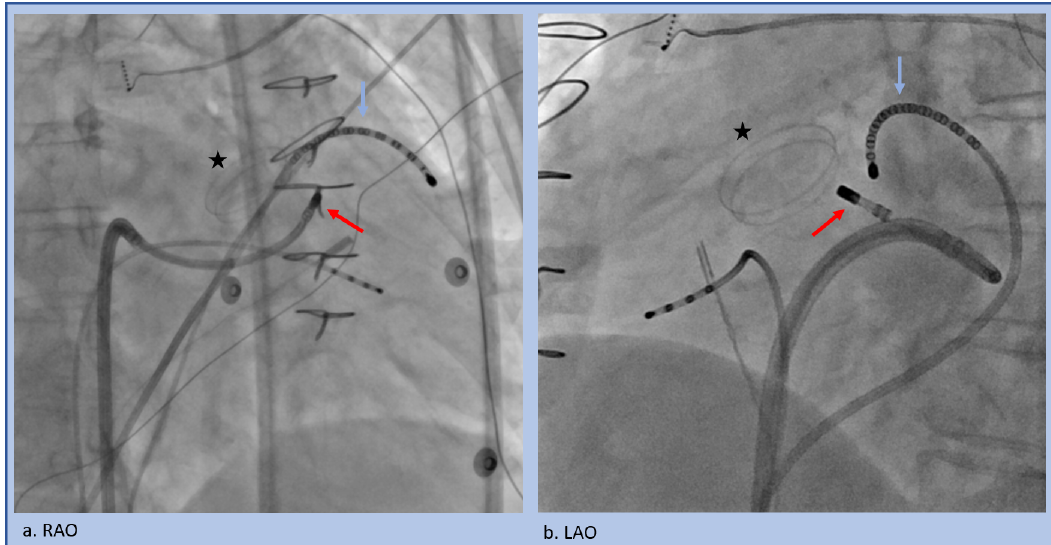
Figure 7. Trans-septal approach to the LSoV in the setting of a mechanical aortic valve (star). A multi-electrode catheter (blue arrow) is pushed through the coronary sinus into the Great Cardiac Vein/Anterior Interventricular Vein junction to span the relevant area. The ablation catheter (red arrow) traverses the trans-septal access and then is flexed back to underneath the LSoV ( a ) RAO projection, ( b ) LAO projection.